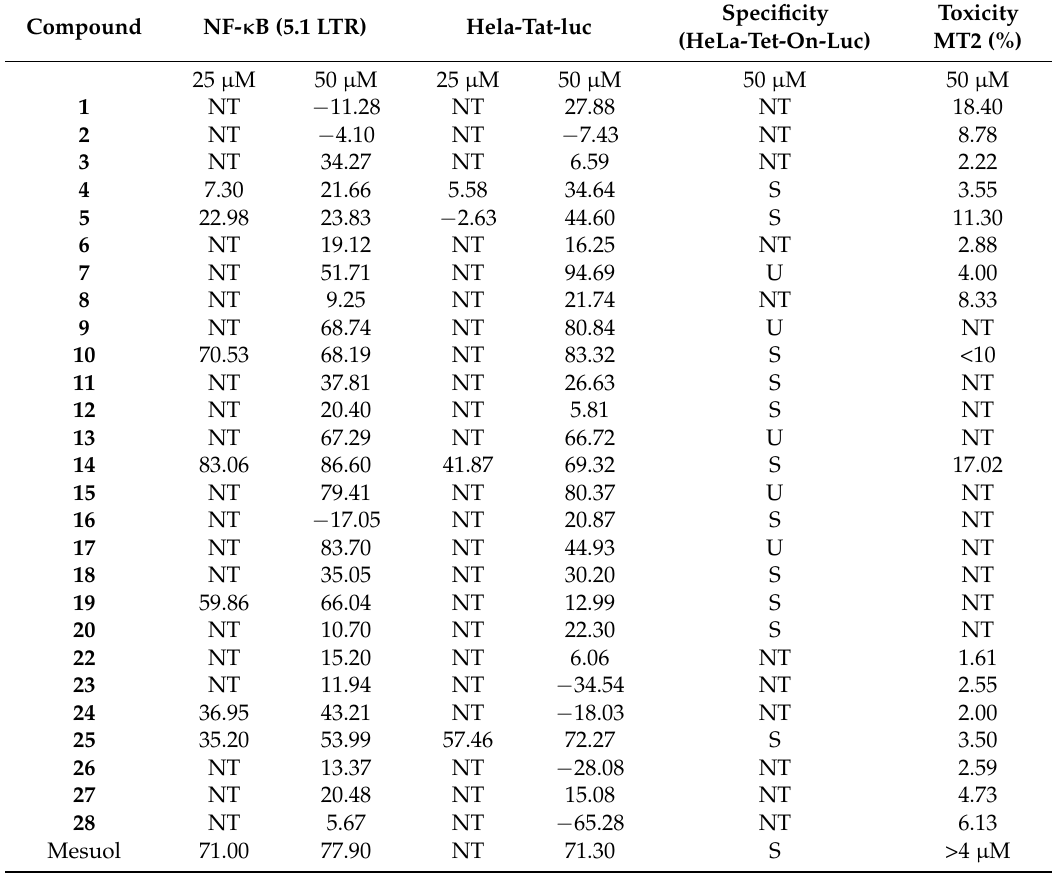
Table 1. Anti-HIV Activity of